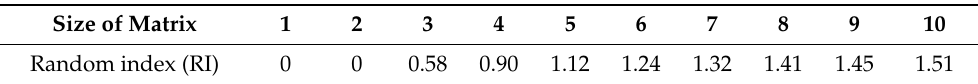
Table 9. Consistency ratio random number index. Source: